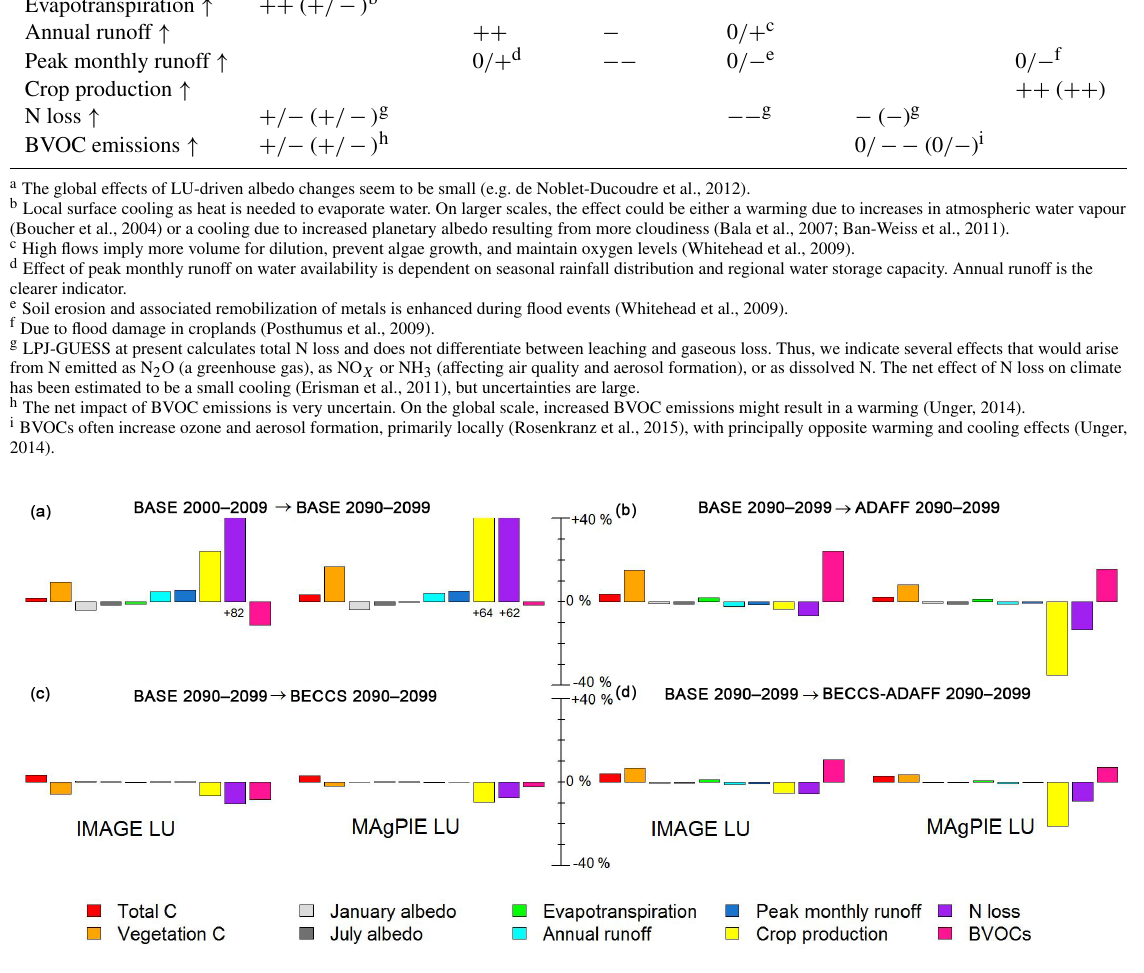
Figure 3. Global relative changes in analysed ecosystem functions simulated by LPJ-GUESS for different LU scenarios from IMAGE and MAgPIE. Changes are capped at ± 40% for clarity reasons, and values exceeding 40% are written below the bar. (a) Changes in the BASE simulation from 2000–2009 to 2090–2099. (b) Changes from BASE to ADAFF by the 2090-2099 period. (c) Same as panel (b) but from BASE to BECCS. (d) Same as panel (b) but from BASE to